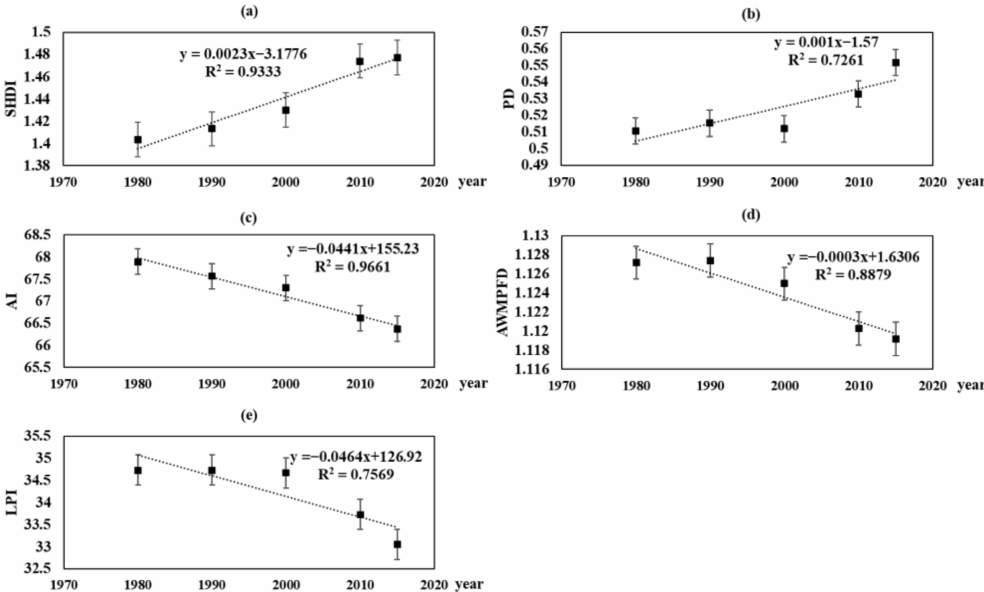
Figure 5. Changes of landscape metrics ( a ) Shannon’s diversity index (SHDI), ( b ) patch density (PD), ( c ) aggregation index (AI), ( d ) area-weighted mean patch fractal dimension (AWMPFD), and ( e ) largest patch index (LPI) at the landscape level from 1980 to